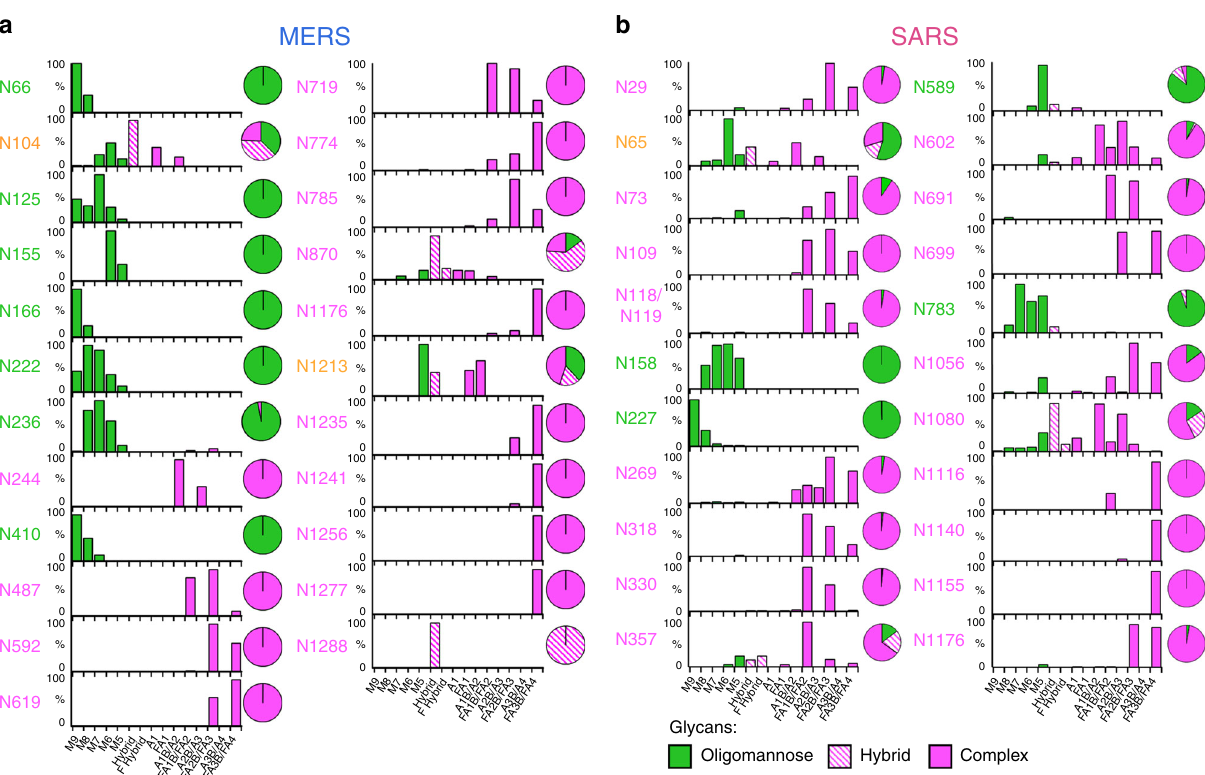
Fig. 2 Quantitative site-speci fi c N-linked glycan analysis of SARS and MERS coronavirus spike glycoproteins. Puri fi ed ( a ) MERS and b SARS S proteins were digested. Quantitative site-speci fi c N-linked glycan analysis of a MERS and b SARS S glycoproteins. Puri fi ed S proteins were digested with trypsin, chymotrypsin, alpha-lytic protease, Glu-C, and trypsin plus chymotrypsin, then analysed by LC-ESI MS. Glycan compositions are based on the glycan library generated from negative-ion mass spectrometry of released N-glycans. The bar graphs represent the relative quantities of each glycan group with oligomannose-type glycan series (M9 to M5; Man 9 GlcNAc 2 to Man 5 GlcNAc 2 ) (green), afucosylated and fucosylated hybrid glycans (Hybrid & F Hybrid) (dashed pink), and complex glycans grouped according to the number of antennae and presence of core fucosylation (A1 to FA4) (pink). Left to right; least processed to most processed. The pie charts summarise the quanti fi cation of these glycans. Additional compositional information regarding the distribution of fucosylation and sialylation can be found in SI Fig.